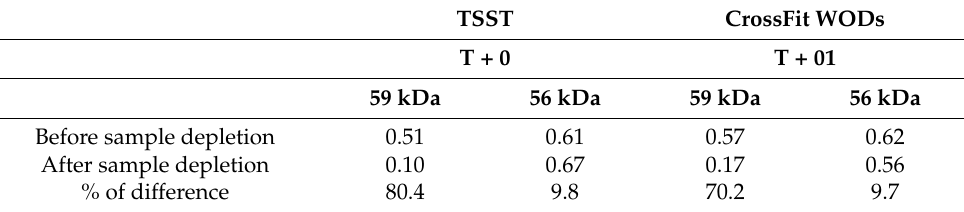
Table 2. Estimated concentration ( µ g) of bands of salivary alpha-amylase at 59 kDa and 56 kDa in the western blot (WB) and percentage (%) of difference before and after a glycoprotein depletion procedure. Saliva specimens were obtained from two pool saliva samples from three individuals who participated in a psychological stress test (the Trier Social Stress Test, TSST, specimen 1) just after the arithmetic task (T + 0), and in an exercise of CrossFit WODs (specimen 2) between rounds (T + 01), respectively. Pool samples were added at 3.0 µ g per lane.